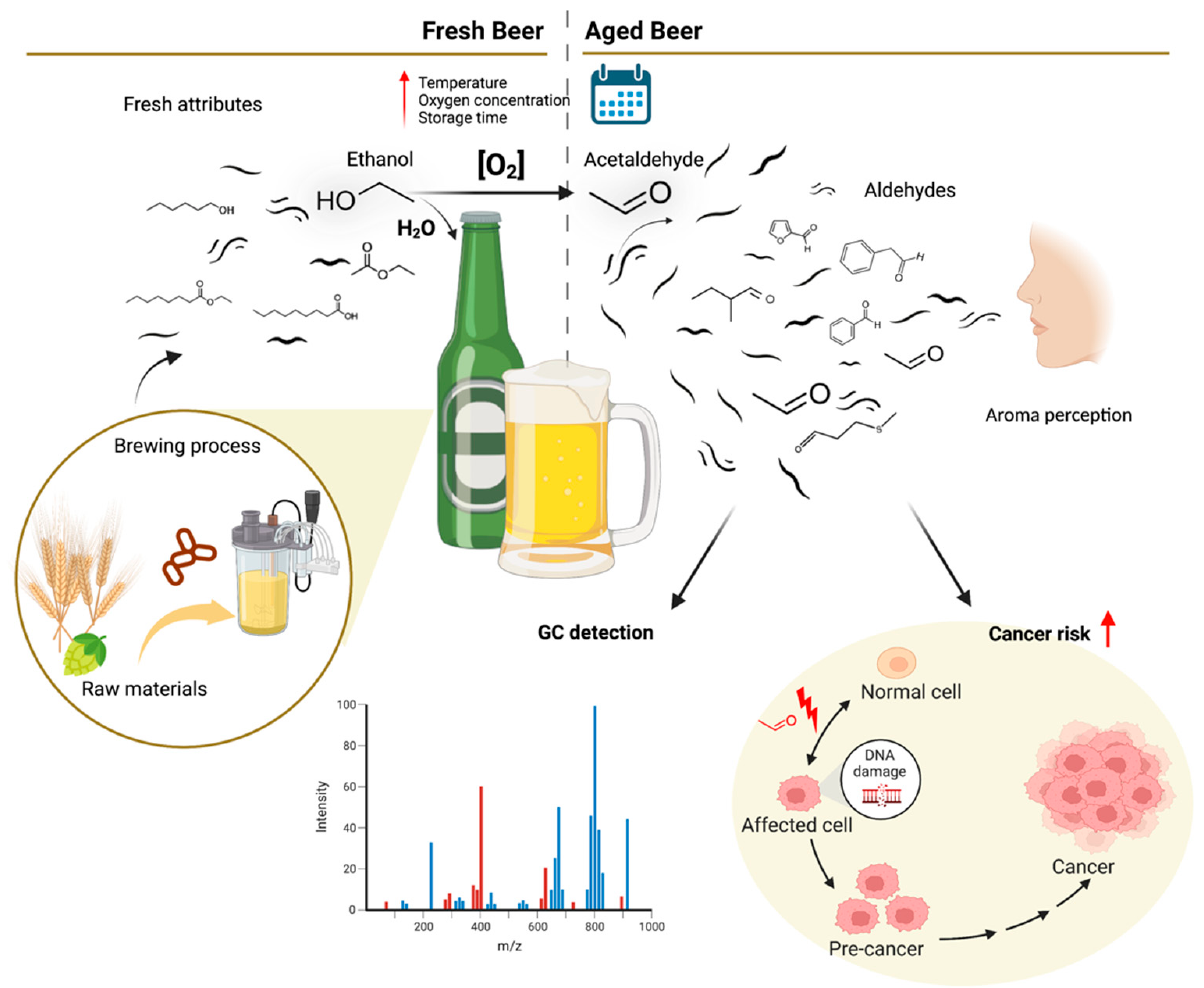
Figure 2. Contribution of volatile compounds identified by gas chromatography coupled to mass spectrometry (GC-MS) to the fresh or stale beer aromas and acetaldehyde impact on cancer risk, created with BioRender.com. Red arrow represents increasing signal.